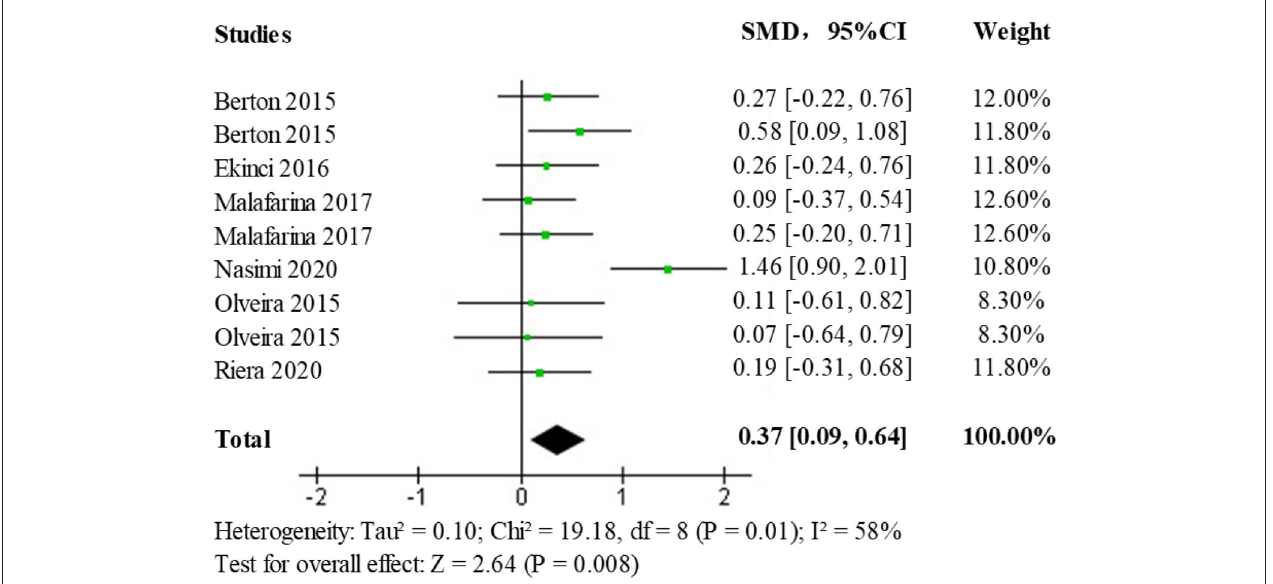
FIGURE 5 | Forest plot of the effect of HMB on upper limb muscle strength in the elderly population.